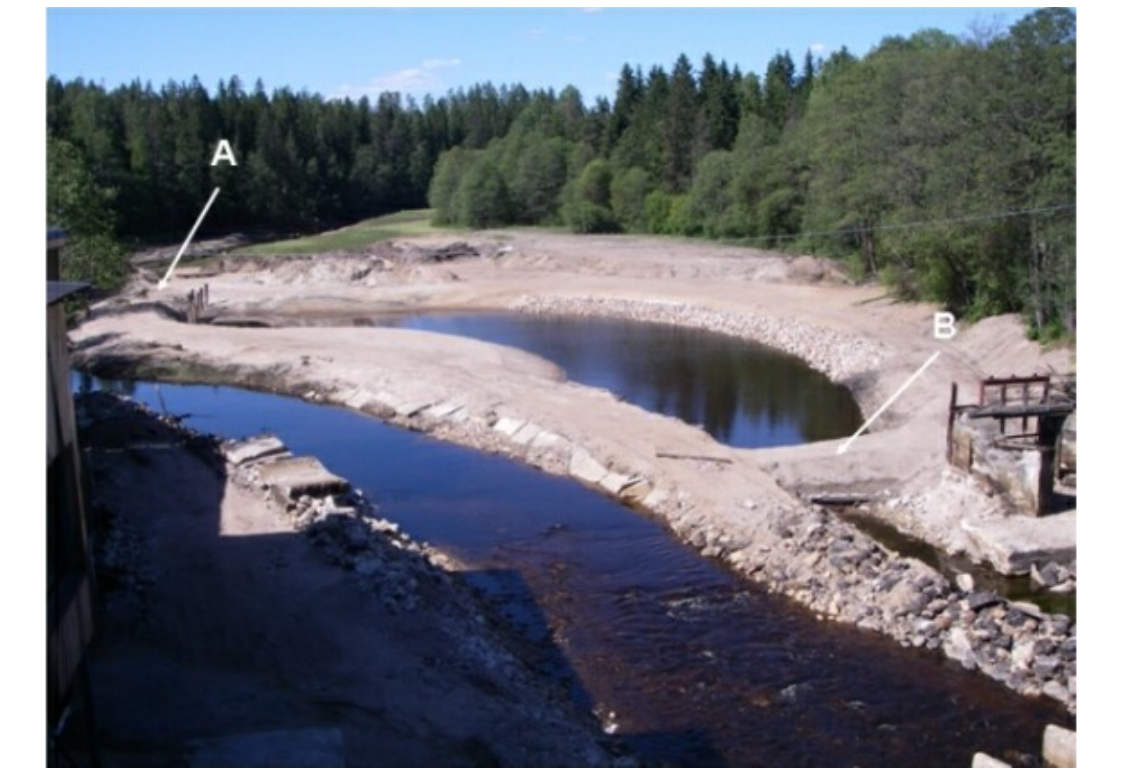
Fig. 4 . Nissan Stream after dam removal in July 2008. The channel is being redug (to the right in the picture) so that the sawmill can expand its log yard out into the natural stretch. This was a demand from the company in return for co-financing and agreeing to the removal. A and B mark the banks that will be removed when the new channel becomes